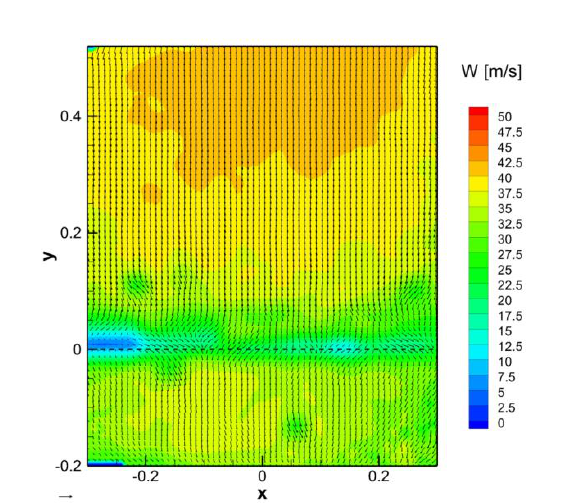
Fig. 17. Mean of-plane velocity component with in-plane velocity vector components. Re =